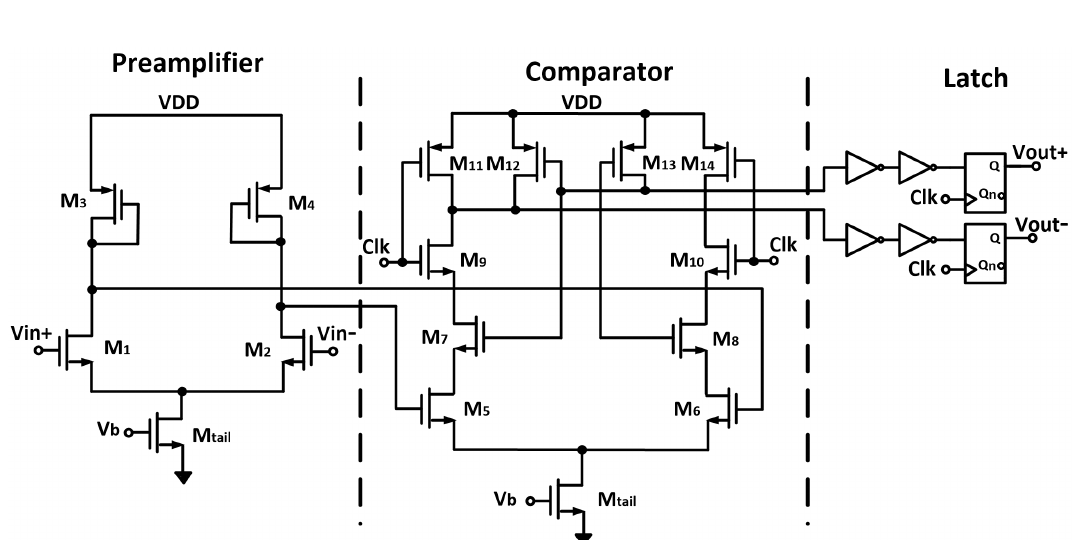
Figure 11. Schematic of the implemented single-bit